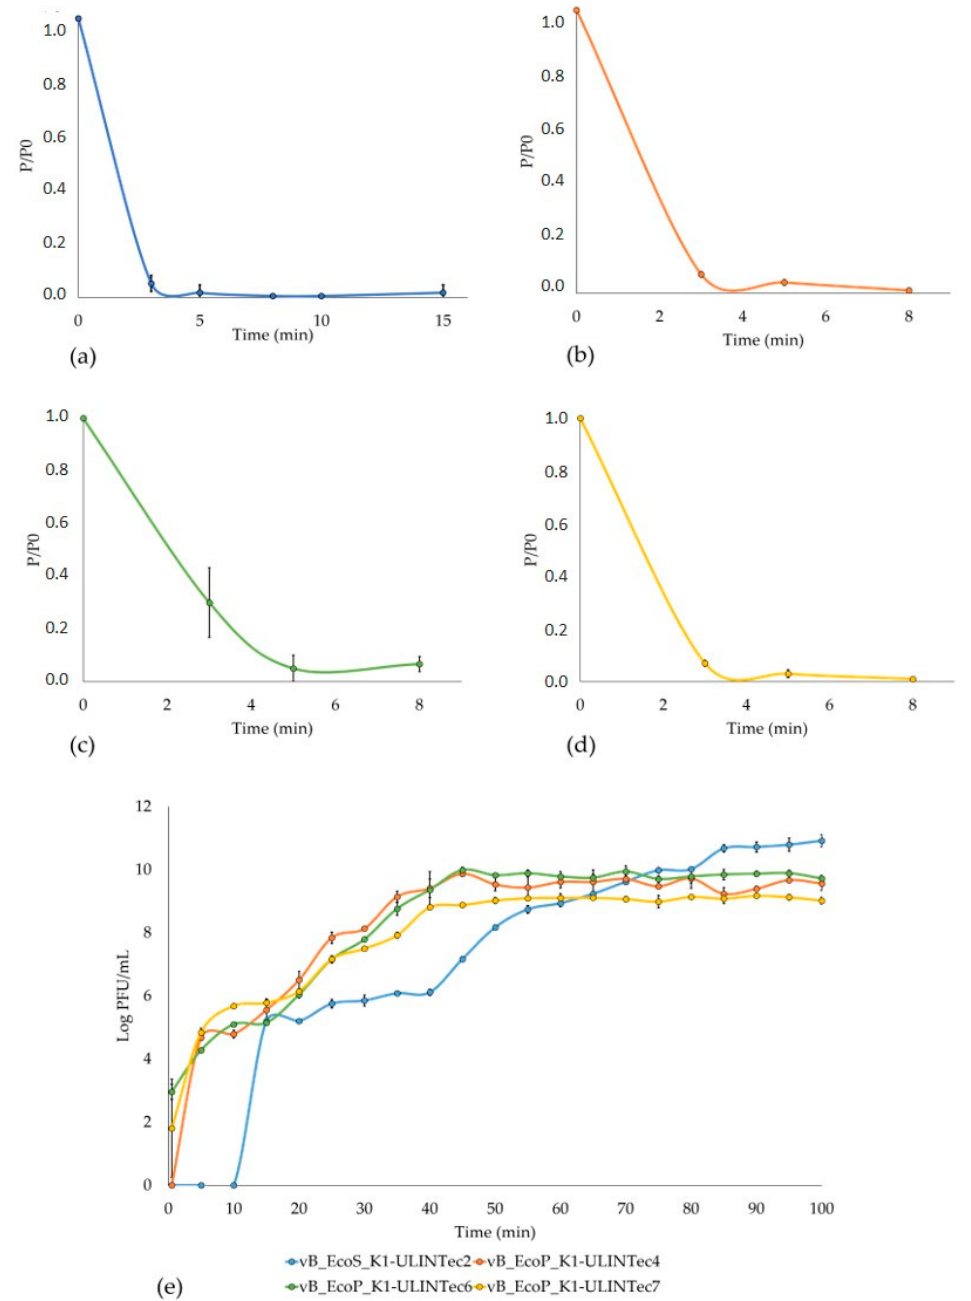
Figure 7. Adsorption time of ( a ) vB_EcoS_K1-ULINTec2, ( b ) vB_EcoP_K1-ULINTec4, ( c ) vB_EcoP_K1-ULINTec6, ( d ) vB_EcoP_K1-ULINTec7, and low MOI phage kinetics ( e ). P 0 : initial phage concentration. P: number of free phages. The results are the mean value of three titrations.